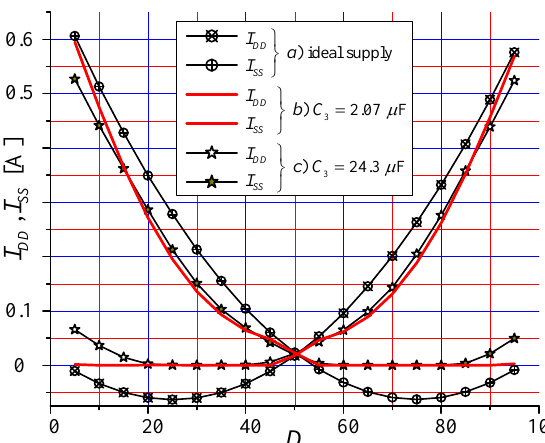
Figure 9. Measured supply currents: ( a ) ideal (bilateral) power supply; ( b ) unilateral power supply and C 3 = 2.07 µ F; ( c ) unidirectional power supply and C 3 = 24.3 µ F.